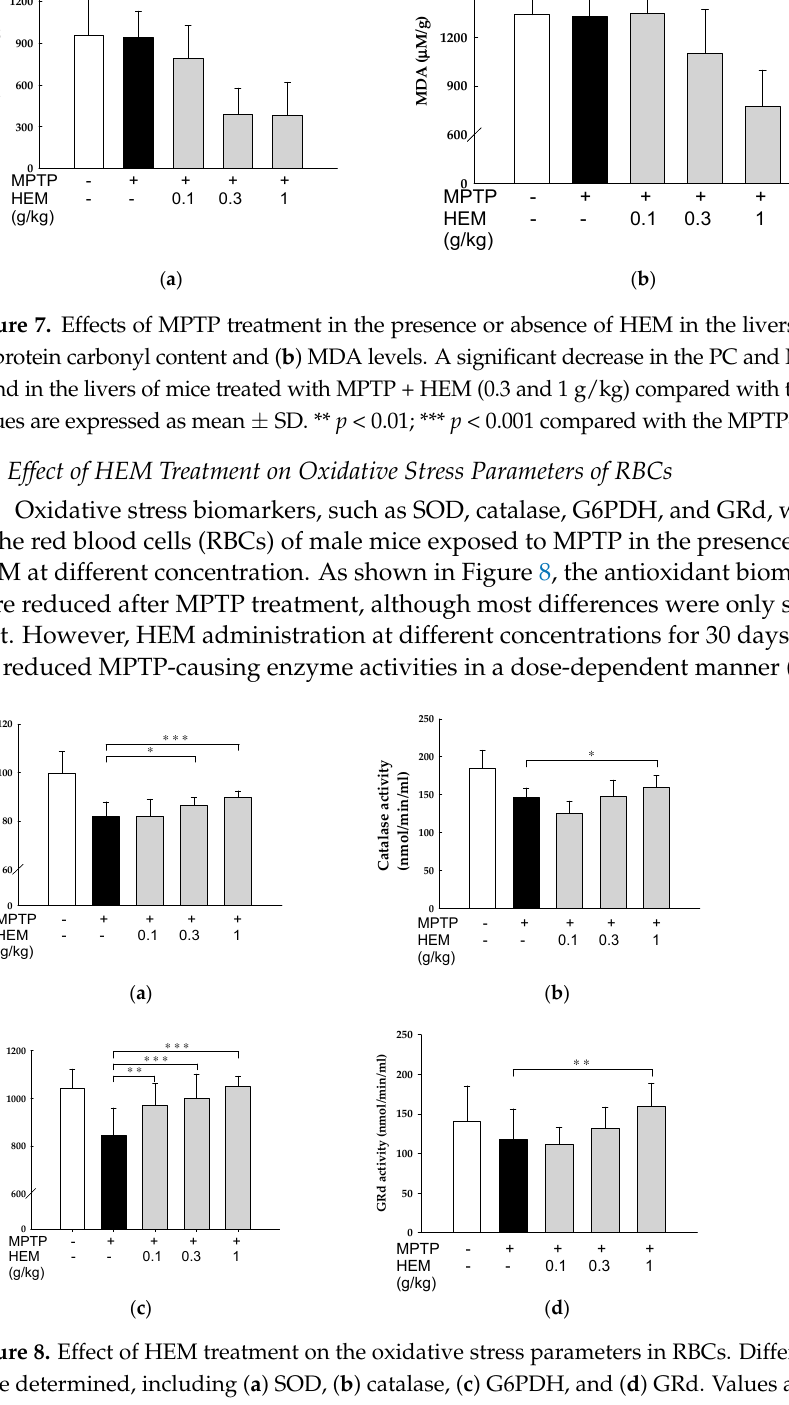
Figure 6. E ff ects of MPTP treatment in the presence or absence of HEM in the brains of mice on the ( a ) protein carbonyl content and ( b ) MDA levels. A signi fi cant decrease in the PC and MDA levels was found in the brains of mice obtained from treatment with a high concentration of HEM (1 g/kg) compared with the MPTP group. Values are expressed as mean ± SD. ** p < 0.01;*** p < 0.001 com- pared with the MPTP − treated group.